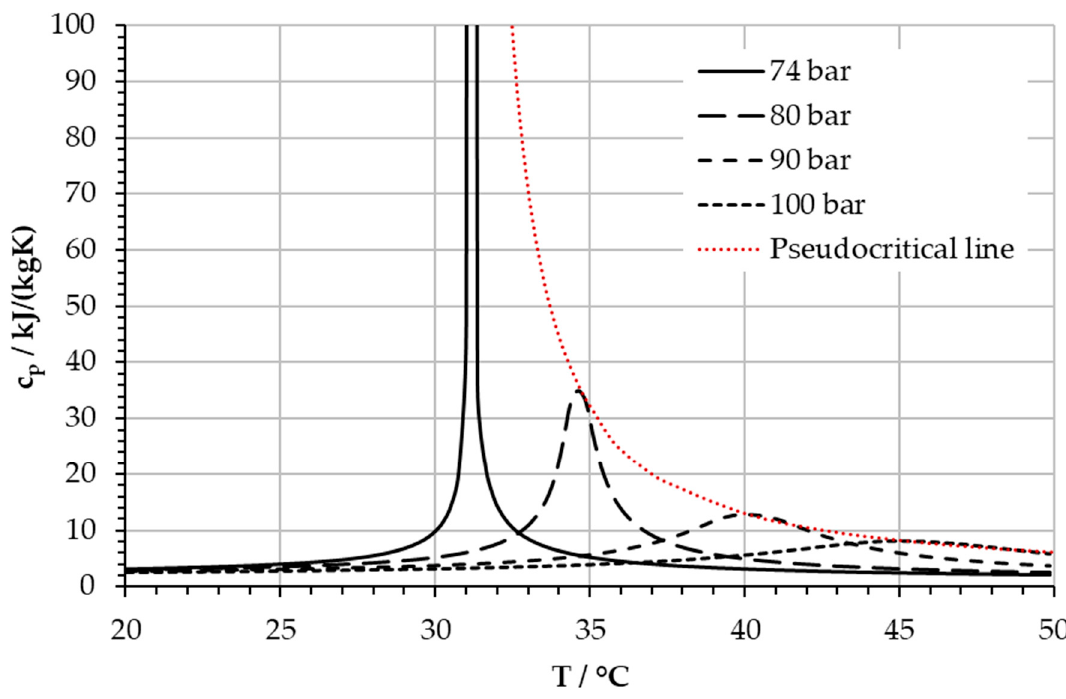
Figure 2. Heat capacity of CO 2 generated with REFPROP (Lemmon et al. [4]) and the critical point of CO 2 at 31 °C and 73.8 bar.